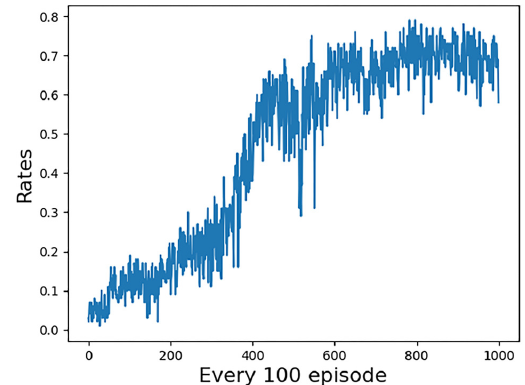
Figure 17. Our UCAV win rate change curve in case 3.